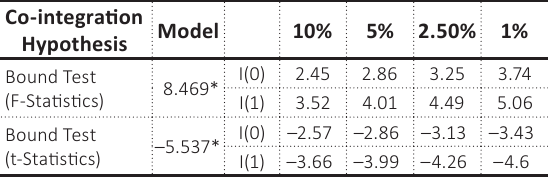
Table 4 estimates the relationship between eco-